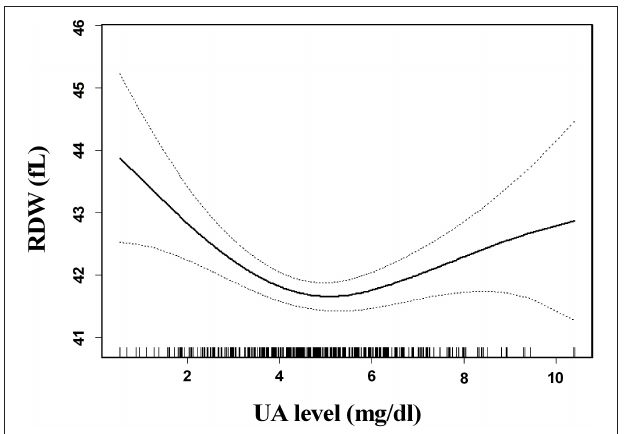
FIGURE 3 | Linear curve fitting of the relationship between SUA levels and RDW by gender. A U-shaped relationship between SUA levels and RDW was detected in women after adjusting for age, hypertension, coronary heart disease, platelets, neutrophils, albumin, fasting blood sugar, creatinine, erythrocyte sedimentation rate, prothrombin time, lipid-lowering drugs, and antiplatelet drugs ( p = 0.006), but there was no significance of U-shaped relationships in men ( p = 0.302). Solid lines represent the fitting curve, and dotted lines represent the corresponding 95%